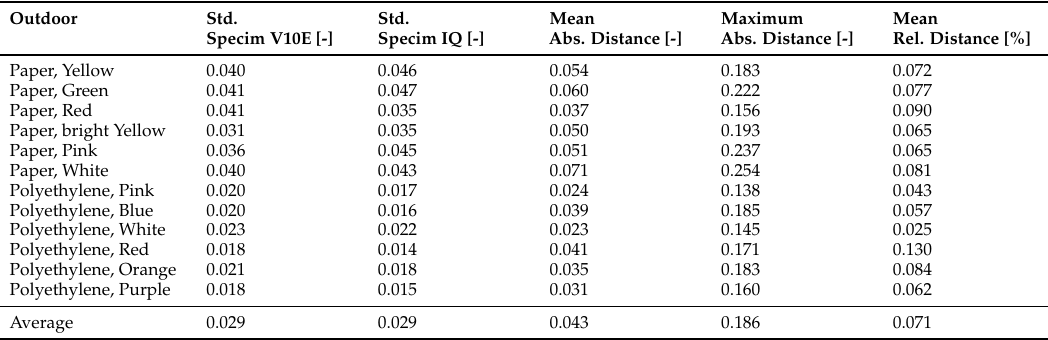
Table A2. Comparative performance parameters of the Specim IQ and Specim V10E observed outdoors under natural light conditions. Mean standard deviation of the homogeneous color cards, the mean absolute distance between the mean spectra, the maximum absolute distance and the mean relative distance in